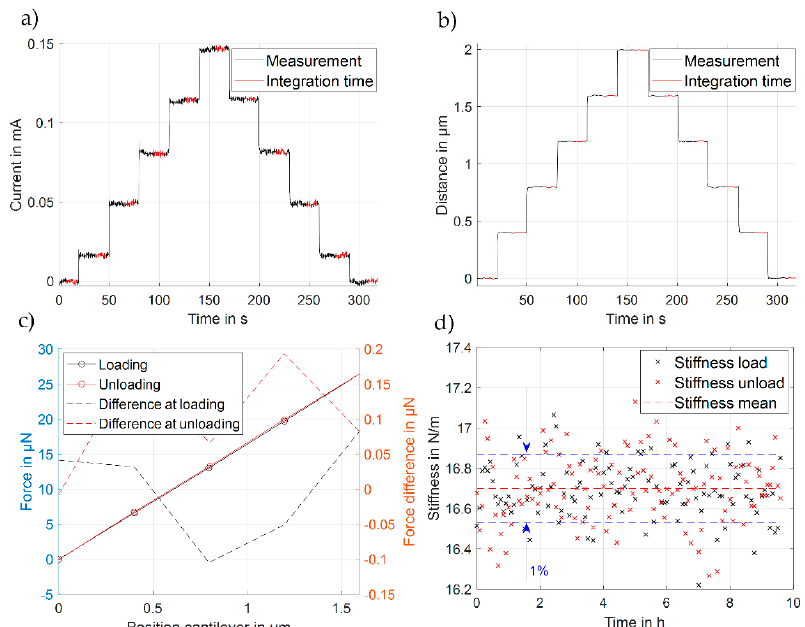
Figure 10. ( a ) Recorded compensation current signal from one cycle with 10 s integration time; ( b ) corresponding measured displacement signal MEMS of one calibration cycle with 10 s integration time; ( c ) Force-displacement characteristics per cycle; ( d ) long-term measurement of MEMS stiffness of the system W 3-1 C1.